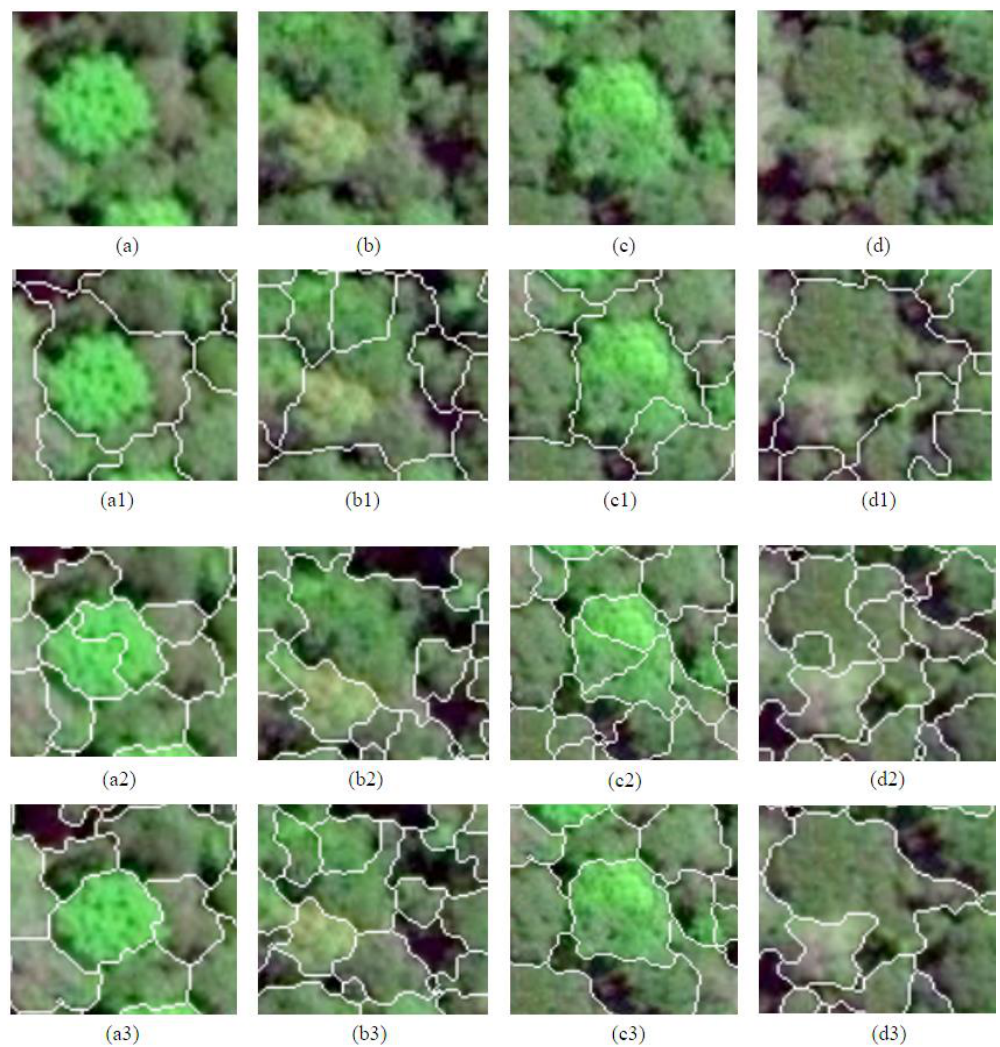
Figure 10. Subsets of the rainforest plot ( a – d ) and the subsets of the tree crown maps obtained by the Crown Slices from Imagery (CSI) ( a1 – d1 ), the commonly used marker-controlled watershed segmentation (MWT) ( a2 - d2 ), and the proposed (SMS) ( a3 – d3 ) methods, respectively.